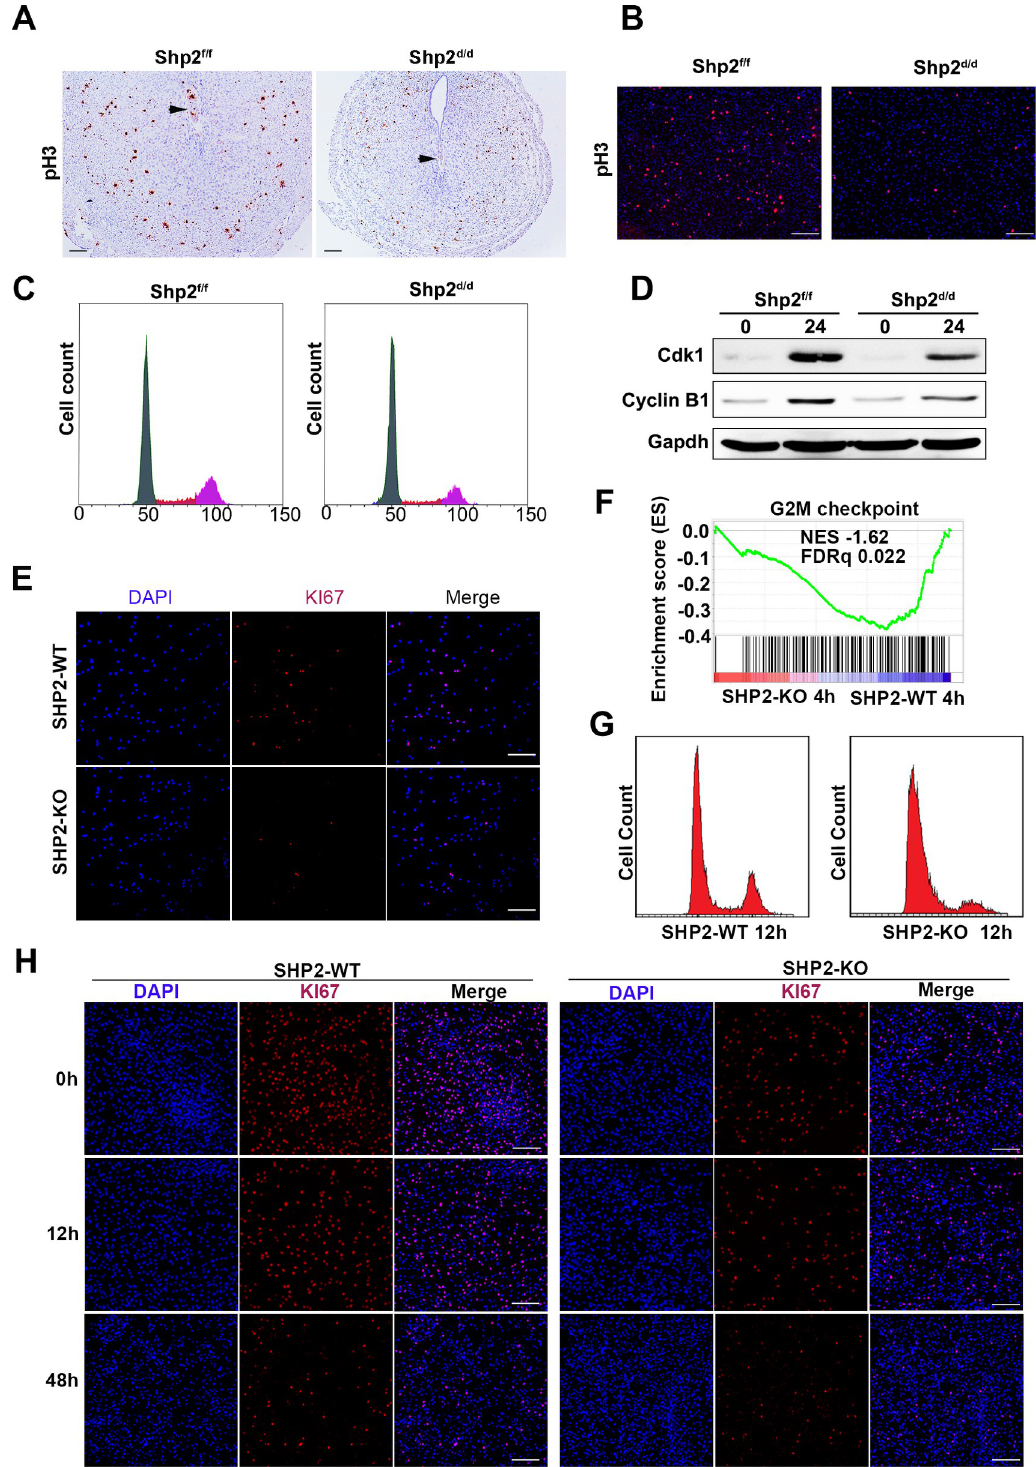
Fig 5. Shp2 knockout disrupts cell proliferation to prevent the differentiation of stromal cells. (A) Immunohistochemical detection of phospho-histone H3 (pH3) at the ISs of Shp2 f/f (n = 6) and Shp2 d/d mice (n = 6) on D6. Scale bars, 100 μ m. (B) Immunocytochemical detection of pH3 in Shp2 f/f (n = 6) and Shp2 d/d (n = 6) primary stromal cells treated with the decidual regimen for 24 h. Scale bars, 100 μ m. (C) Cell cycle distribution of PI-stained hESCs at different time points during the decidual